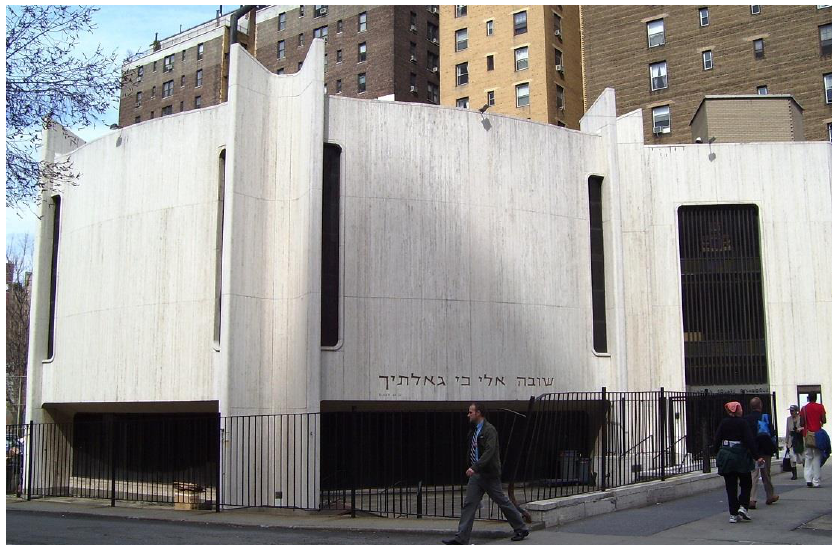
Figure 1. Lincoln Square Synagogue, 1966–70, Hausman & Rosenberg, photo Wikimedia Commons, accessed 22 July 2019. Used by permission.